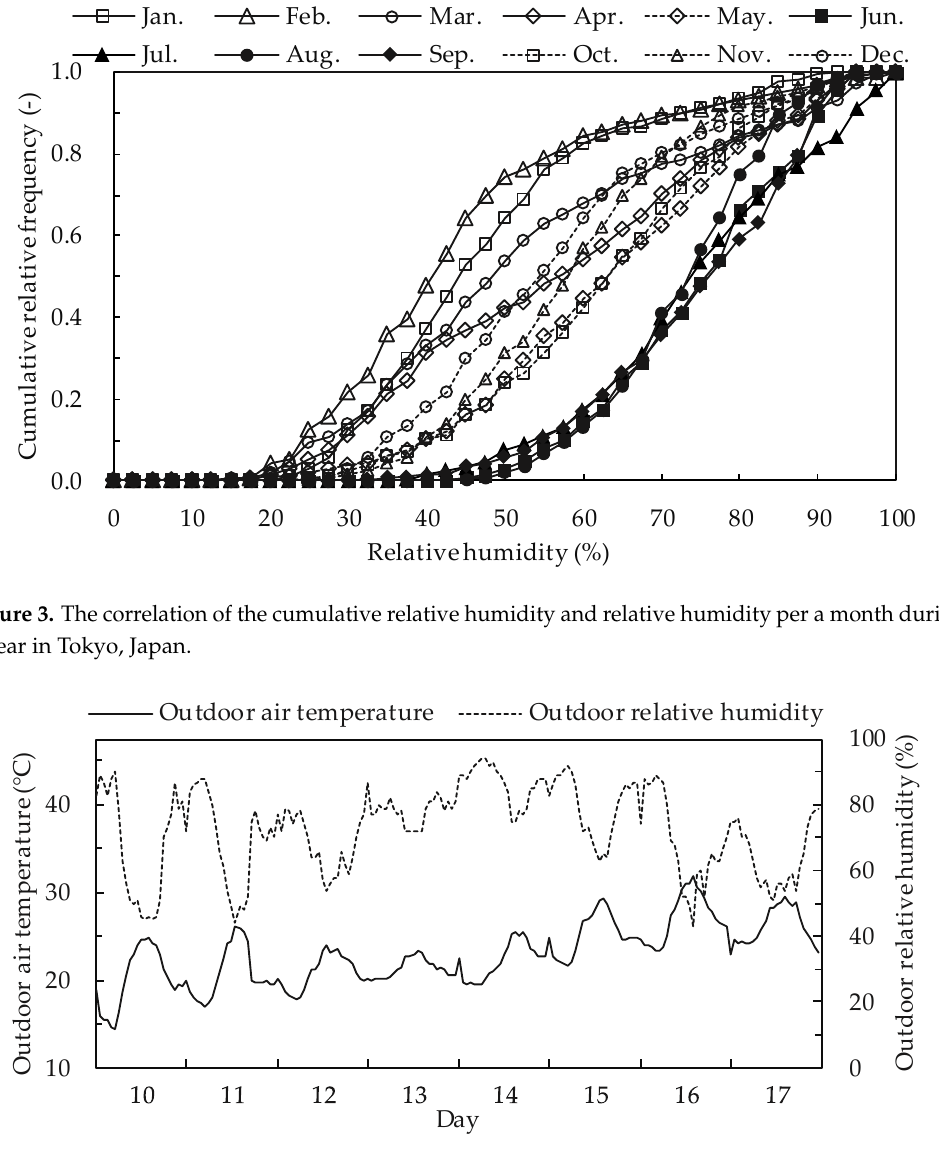
Figure 4. Outdoor air temperature and relative humidity of Tokyo according to the AMeDAS standard weather data (10–17 June).